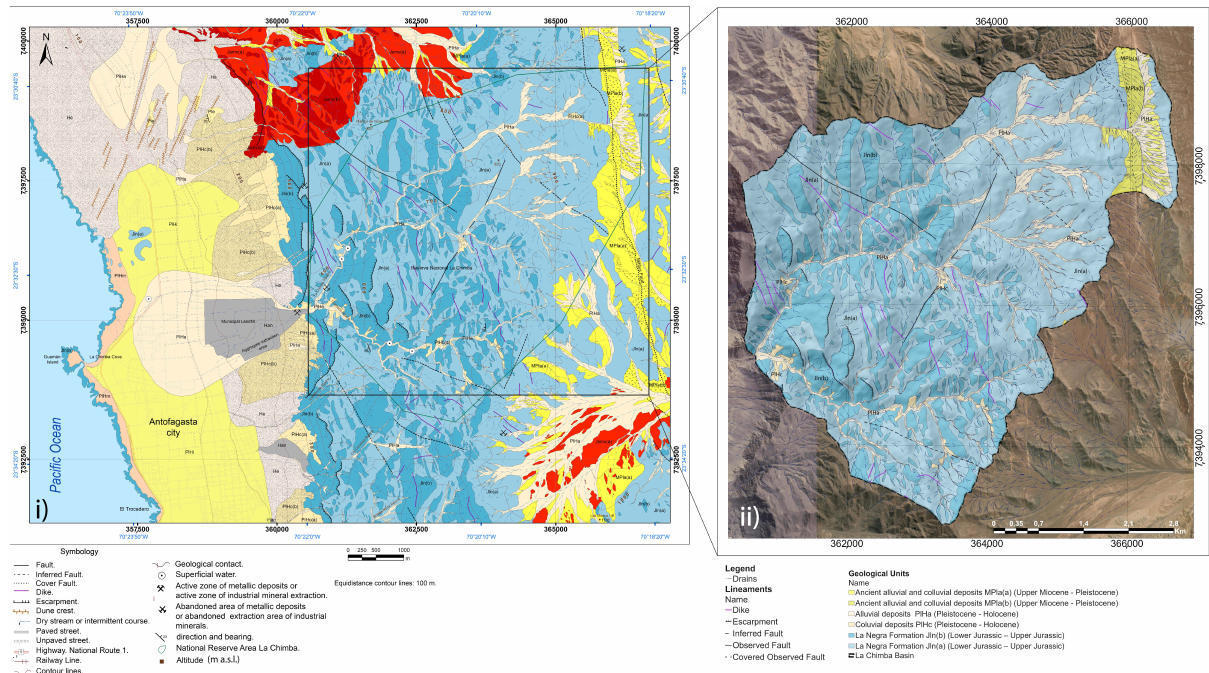
Figure 9. Geological units in the northern area of the city of Antofagasta. ( i ) Geological map of the study area. ( ii ) Geological map of La Chimba basin. Han. Anthropic deposits (Holocene). He. Active eolic deposit (Holocene). PlHa. alluvial deposits (Pleistocene – Holocene). PlHc. colluvial deposits (Pleistocene – Holocene) with (b) and without (a) sedimentary intercalations or covers of aeolian sands. PlHi. undifferentiated sedimentary deposits (Pleistocene – Holocene). PlHm. marine deposits (Pleistocene – Holocene). Ple. inactive aeolian deposits (Pleistocene). MPa. old alluvial and colluvial deposits (Upper Miocene – Pleistocene) with (b) and without (a) salt crust cover. Jln. La negra Formation (Lower Jurassic – Upper Jurassic) with (a) and without (b) regolith coverage. Jsmv. quartz diorite and Mantos de Varas tonalite (Upper Miocene – Pliocene) with (a) and without (b) regolith coverage. The delimitation of geological units underlying urban areas is approximate, due to the difficulty of access and visualization. Data from this work and modified from [23,53 – 55].